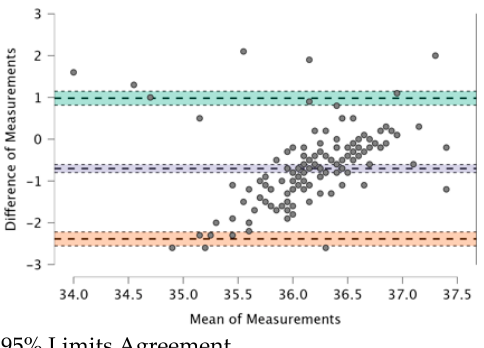
Figure 5. BT–Axillar Electronic TM and BT–Non-Contact Infrared TM (Forehead).